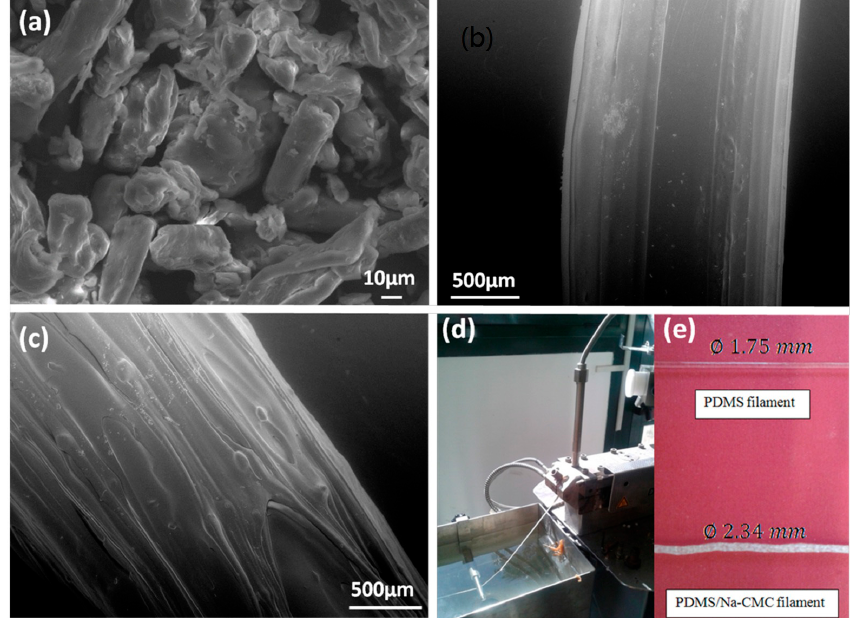
Figure 3. Scanning Electron Microscopy (SEM) images of the ( a ) employed Na–CMC powder; ( b ) bare PDMS filament surface; ( c ) Na–CMC/PDMS composite filament; photographs of ( d ) one filament during the extrusion process and ( e ) the two kinds of obtained filaments.